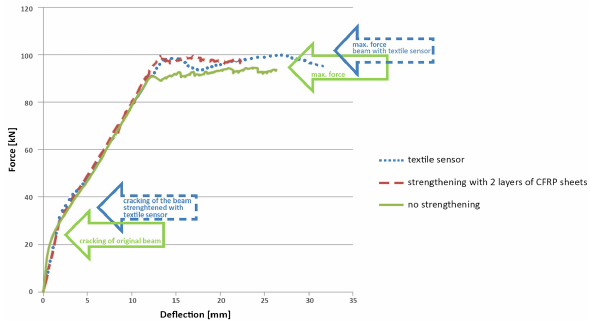
Figure 7: Comparison of Force-Deflection curves for beams with no strengthening, beam with textile sensor and beam strengthened with two layers of Carbon Fibre Reinforced Polymer sheets.